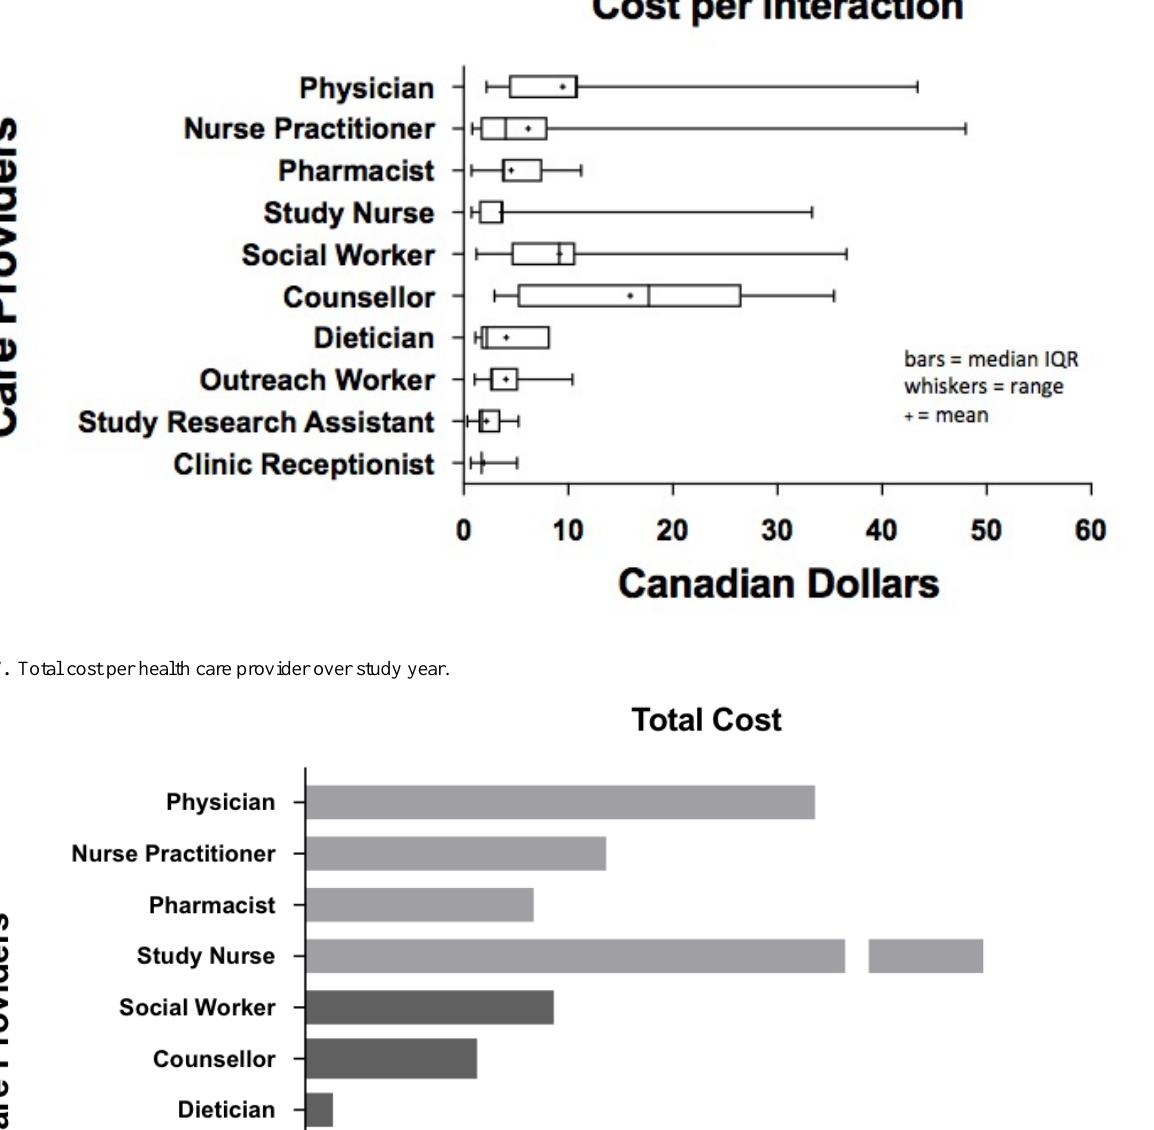
Figure 6. Cost per interaction per health care provider.